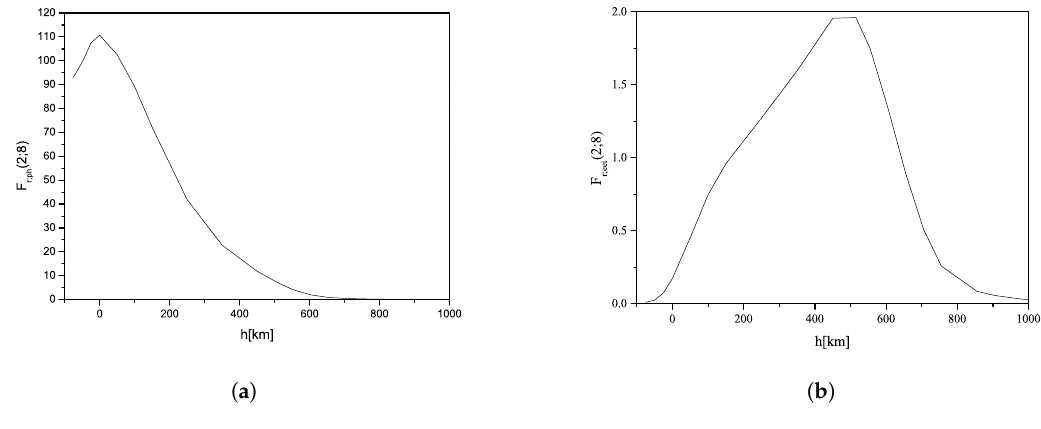
( ab ) ( n , T ) (8) as functions of the height h of the solar atmosphere; ( b ) same as phr ( ab ) ( n , T ) eei